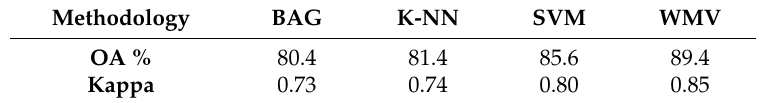
Table 1. The OA and Kappa results of all methods for benthic habitats detection for Shiraho area.